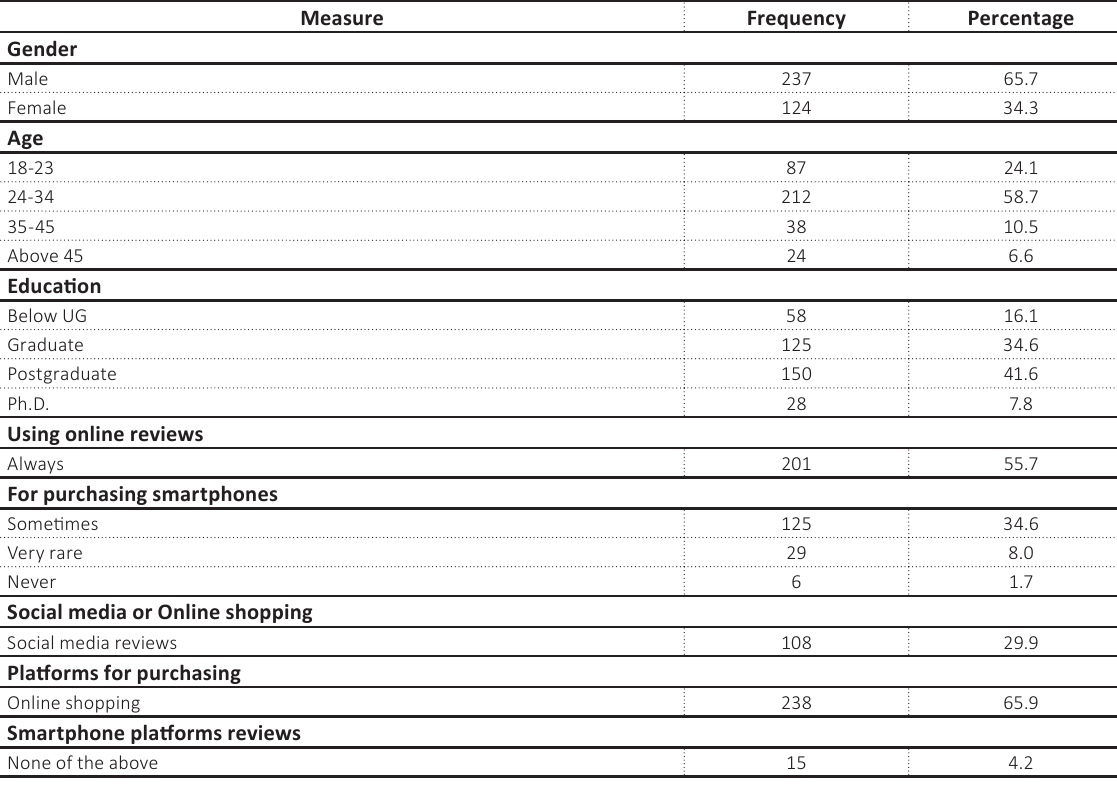
Table 2. Respondents’ demographics